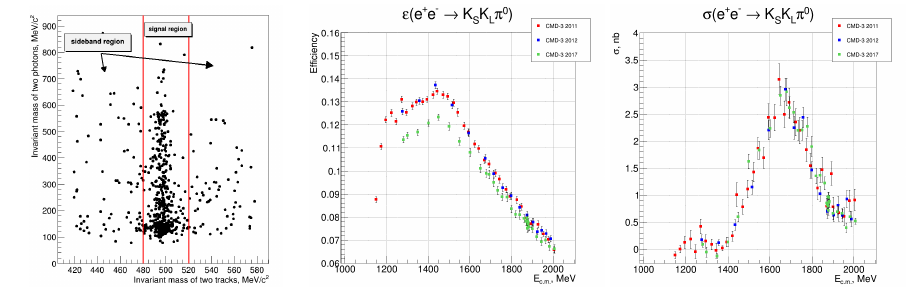
Figure 5. Cross section of the process e + e − → K S K L π